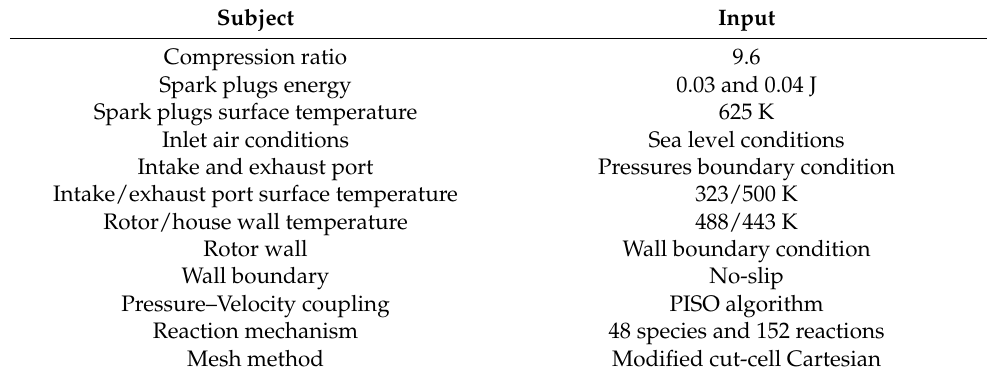
Table 2. Summary of the test engine operating parameters and boundary conditions.